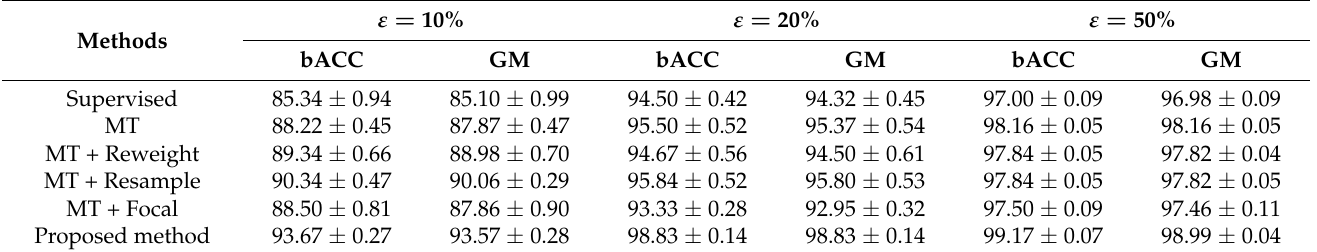
Table 2. Classification performance comparison on the assembly test set (bACC(%)/GM(%)). Methods